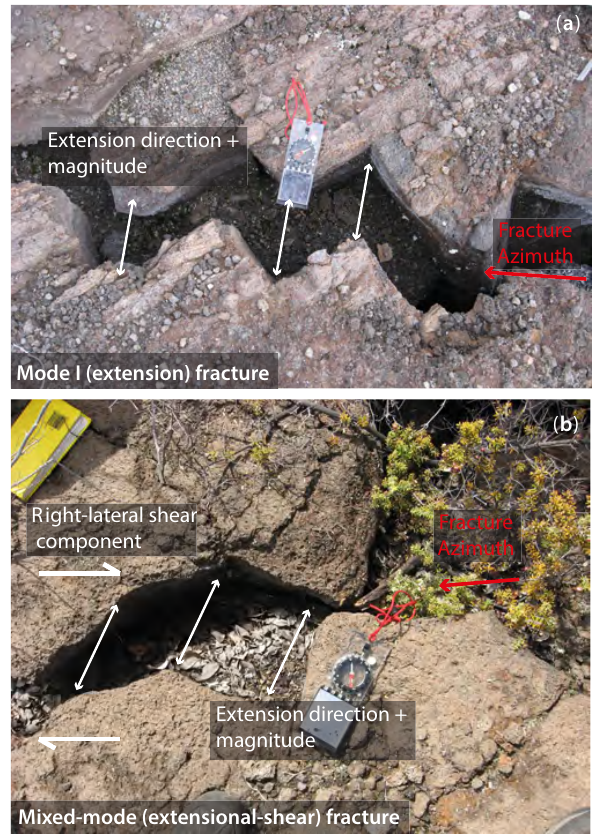
Figure 2. Measurement of fracture geometry and kinematics. (a) Mode I (extensional) opening across pre-existing cooling joint sur- faces allows the traditional measurement of extension direction and magnitude (aperture) and fracture trace azimuth. The fracture in the image shows an aperture of 0.2m and an opening direction of 142 ◦ , orthogonal to the azimuth of the fracture (052 ◦ ). (b) Mixed-mode (extensional shear) opening across a cooling joint. The fracture in the image shows an aperture of 0.25 m and an opening direction of 036 ◦ , oblique to the azimuth (080 ◦ ) of the fracture, indicating a component of right-lateral